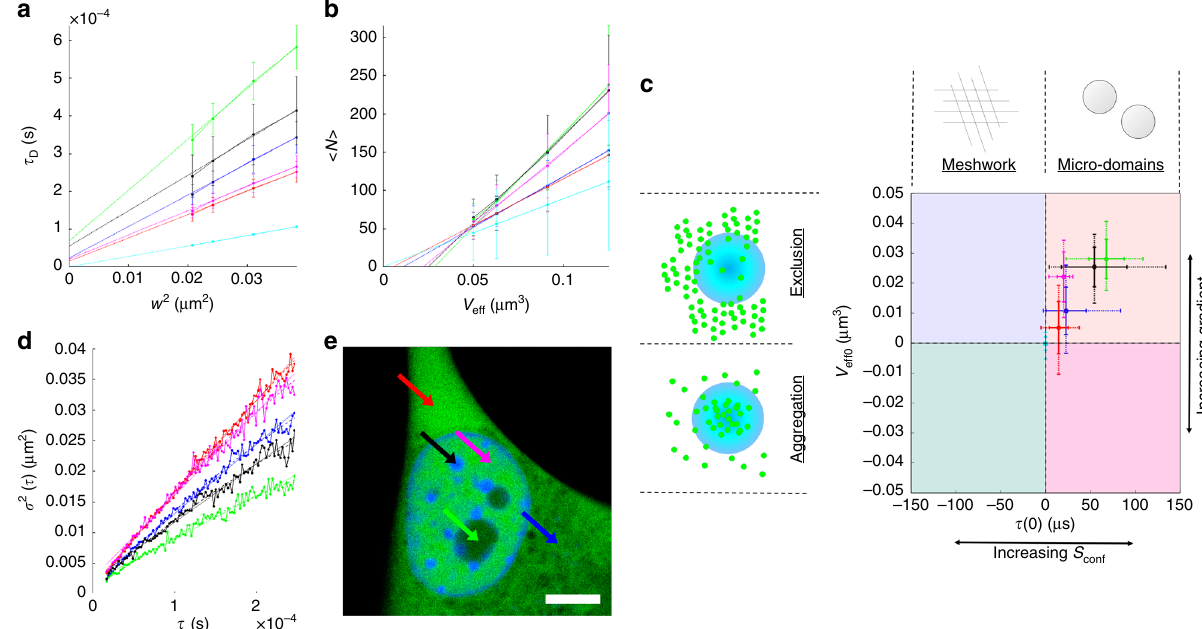
Fig. 4 Spot-variation curves for diffusion time ( a ) and number ( b ) from which the intercept plot ( c ) is constructed, along with the iMSD curves ( d ) for several cellular compartment shown in e , namely unstructured (red) and structured (blue) cytoplasm, heterochromatin- (black) and euchromatin-rich (magenta) nucleoplasm, nucleolus (green) and free EGFP in solution (cyan). Dashed lines in a , b show the linear fi tting of the curves while dotted and dashed lines in d show the fi tting with a free diffusion and a con fi ned model, respectively. Scale bar in e is 5 μ m. Solid error bars denote the standard deviation computed from 25 cells, while dashed error bars denote the extremes of the